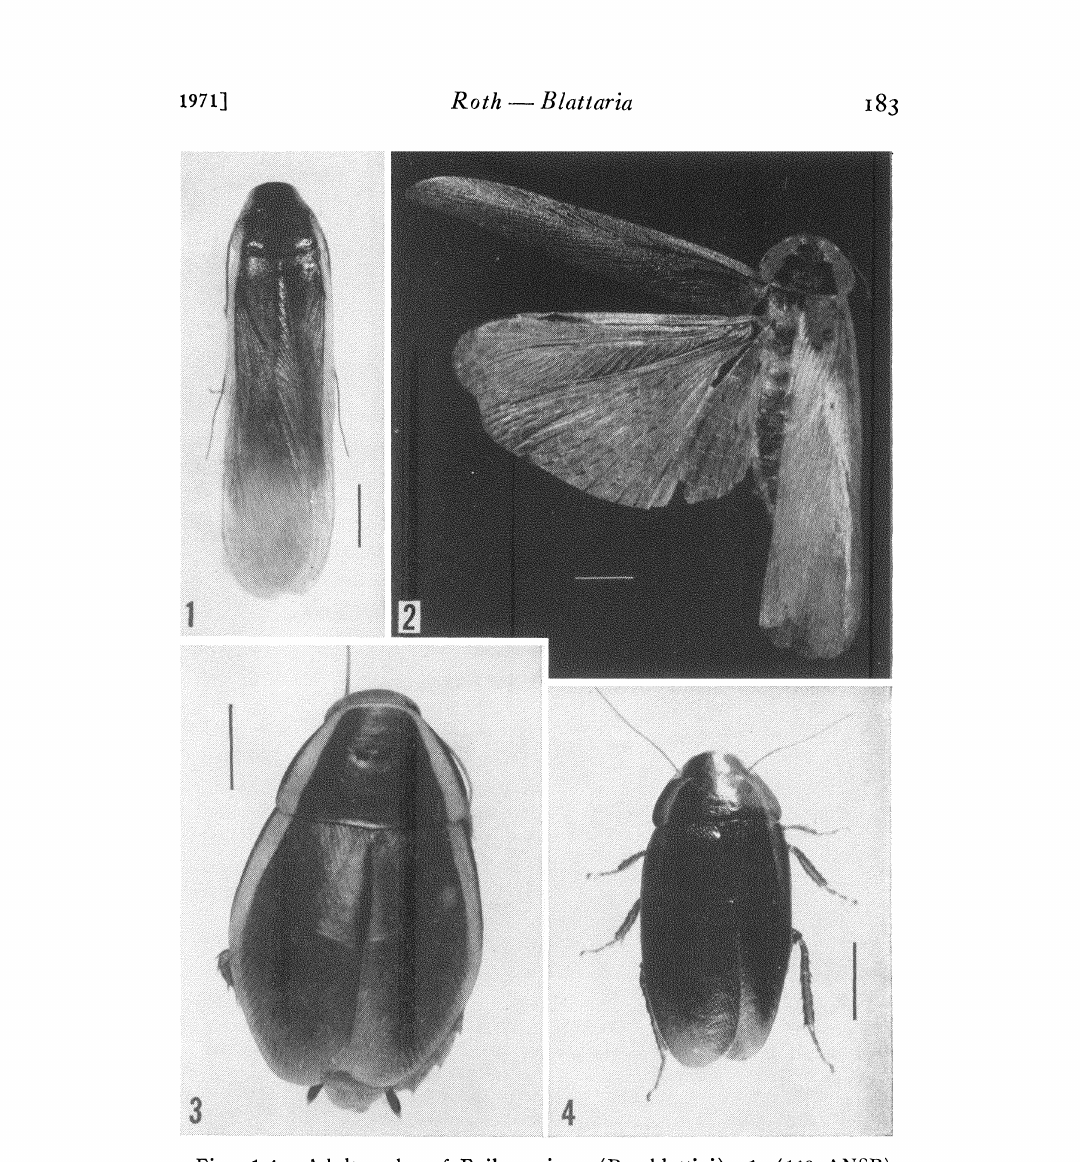
Figs. 1-4. Adult males of Epilamprinae (Poroblattini). 1. (118 ANSP). Poroblatta sp. Sierra San Lorenzo, Magdalene, Colombia. 2. (116 ANSP). Colapteroblatta compsa Hebard. Type. San Lorenzo, Santa Marta, Colom- bia. 3. (17 MCZ). Dryadoblatta scot’ti (Shelford). Mount Tueuehe, Trini- dad (type locality) (det. Darlington). 4. (USNM). Galiblatta illiamsi Roth. Taruma-Aeu, about 15 Km. northeast of Manaus, Amazonas, Brazil (from Roth, 1968). (scale 5